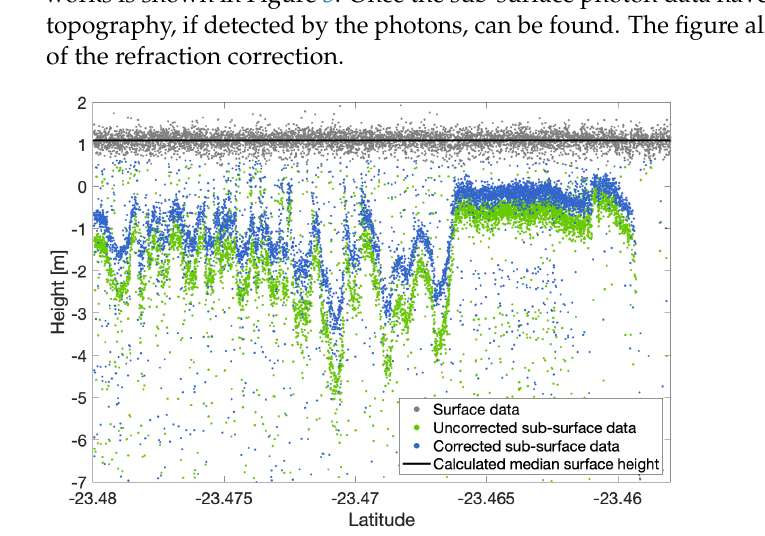
Figure 3. Illustration of discrimination procedure using a track crossing Heron Reef on 15 September 2019 (beam gt1r). Surface points are shown in grey, with the median surface height in black, sub- surface points before the refraction correction are shown in green. Blue points correspond to the subsurface data after the refraction